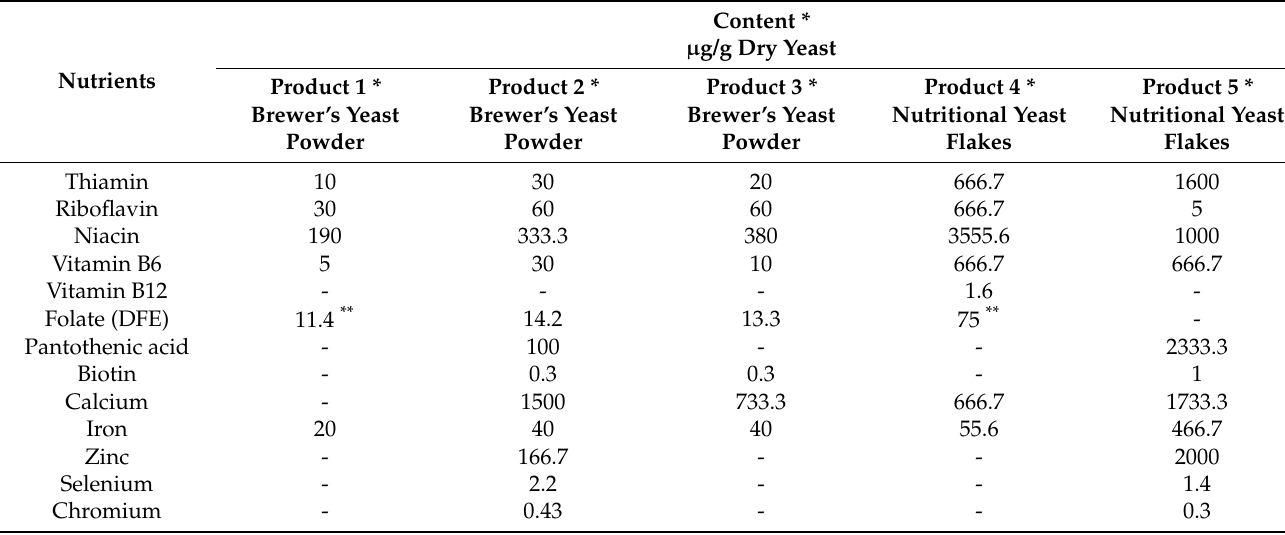
Table 2. Description of B vitamin and mineral concentrations in a selection of commercially available Saccharomyces cerevisiae yeast-based supplements